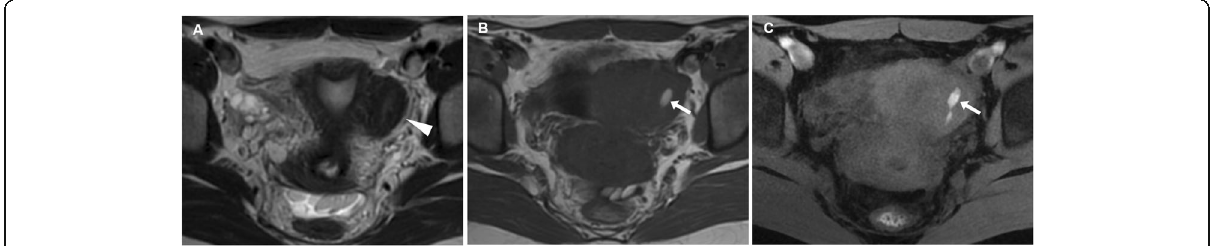
Fig. 4 Leiomyoma with haemorrhagic degeneration in a 25-year-old woman suffering from acute pelvic pain. Oblique-coronal T2-weighted image ( a ) shows a subserosal leiomyoma, with predominant low signal intensity, arising from the left lateral wall of the uterus (arrowhead). On oblique-axial T1-weighted ( b ) and fat-suppressed T1-weighted ( c ) images, the mass demonstrates a central region of hyperintense signal (arrows) corresponding to haemorrhagic